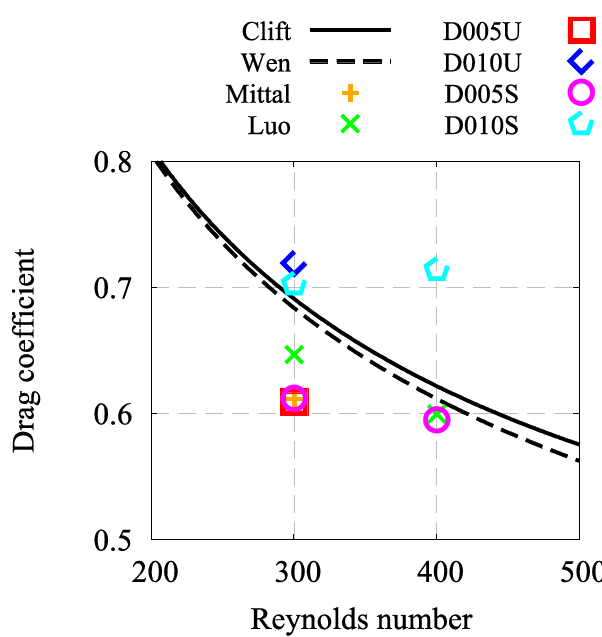
Figure 4. Drag coefficients versus Reynolds number computed using the proposed model (red and blue symbols), drag model (black lines) and previous models (orange and green symbols).